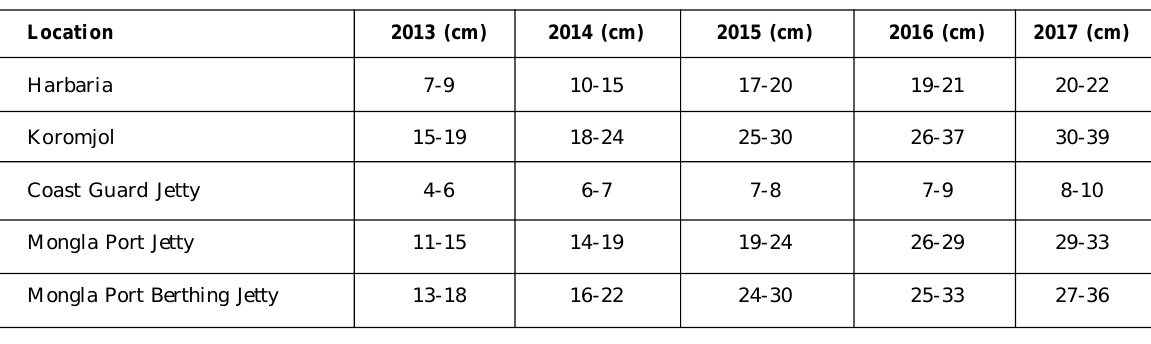
Table 5: Rate of River Bed